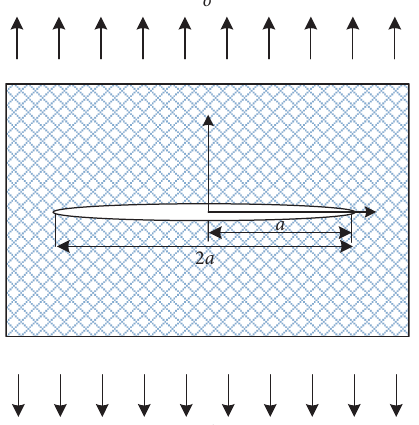
Figure 1: A central Mode I crack of length 2a in an infinitely wide concrete plate.